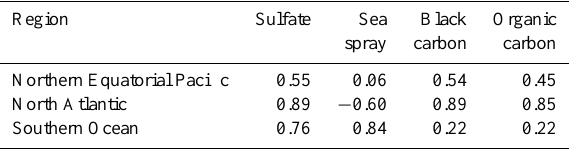
Table 1. Pearson coefficients for monthly mean CCN and monthly mean aerosol component mass from the fifteen-year simulations.